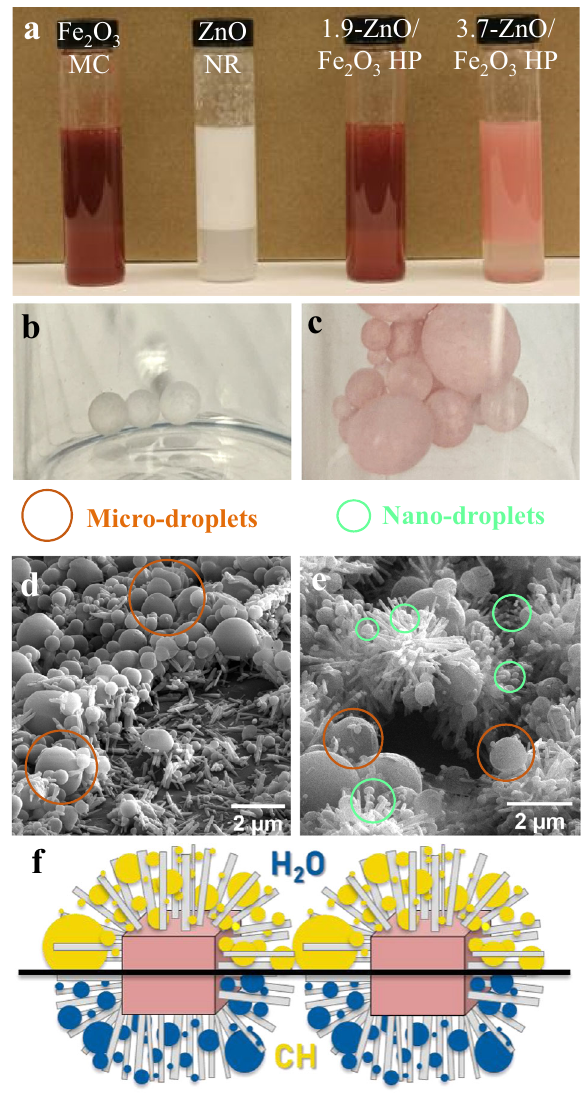
Fig. 2 | Emulsions of hedgehog particles and their component parts. Pickering emulsionsformedafterdispersingcatalystsinamixtureof1:1(byvol)cyclohexane andwaterafter1min a .Macroscaledropletsformedduringthepolymerizationofa 1:1 styrene/water emulsion for ZnO NR b and 3.7-ZnO/Fe 2 O 3 HP c . Multiscale het- erogeneity observed in SEM images of the surface of large macroscale polymer dropletsshowingmicro-andnano-dropletsinteractingwithZnONR d and3.7-ZnO/ Fe 2 O 3 HP e . Graphic depicting behavior of dispersed HPs at the CH/H 2 O interface with micro- and nano-droplets f